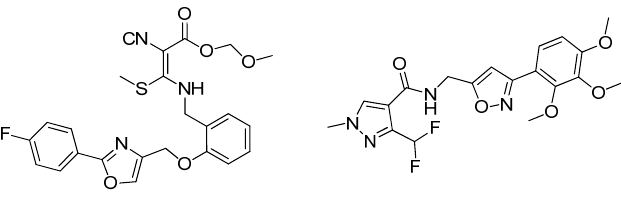
Figure 2. Chemical structures of oxazole derivatives.